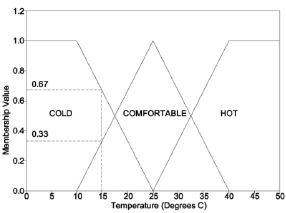
Figure 1. Room temperature from Hayward and Davidson